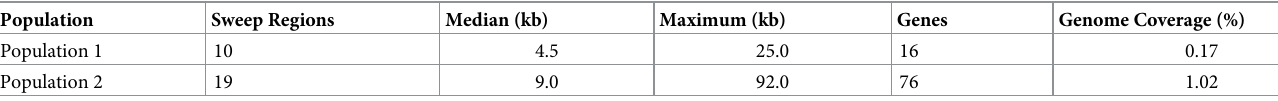
Table 3. Detection of selective sweeps in two P . nodorum